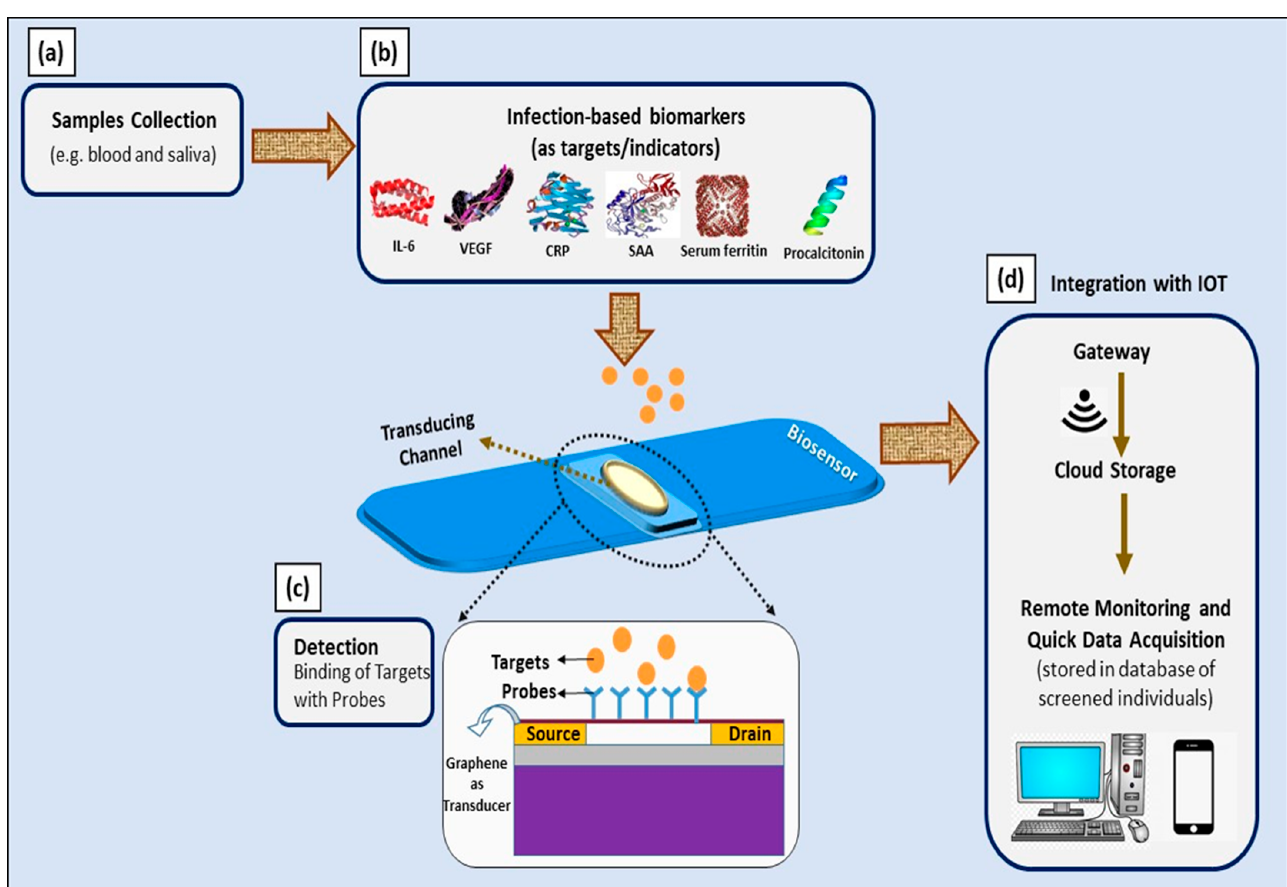
Figure 7. Schematic illustration of utilizing infection-mediated clinical biomarkers as adjunct diagnostic and prognostic indicators in developing electrical-based COVID-19 biosensors for point-of-care application. ( a ) Samples collected from infected individuals; ( b ) infection-mediated clinical biomarkers comprising IL-6, VEGF-D, CRP, SAA, serum ferritin, and procalcitonin as targets; ( c ) graphene-based FET device as a biosensor and electrical changes upon binding of targets with probes, measured with three-point probe measurements; and ( d ) integration with IoT for remote monitoring and quick data acquisition.